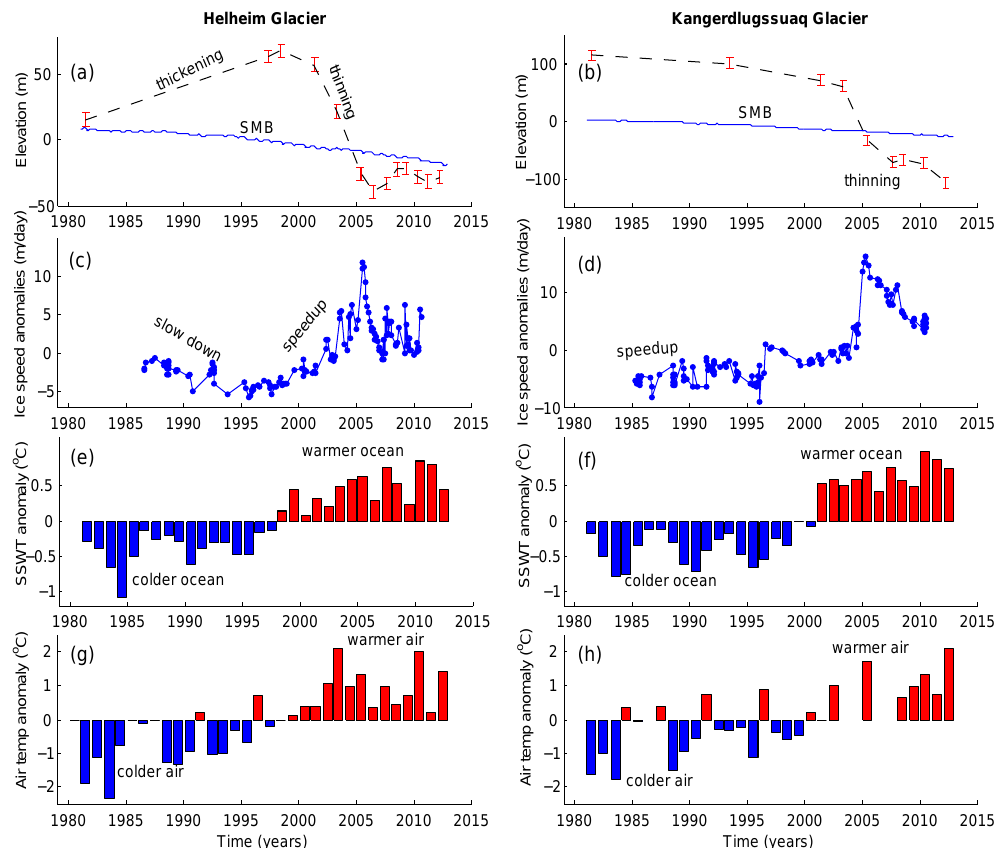
Figure 7. Time series of surface elevation change, surface velocity, sub-surface water temperature (SSWT), and air temperature. (a) : Time series of elevation change relative to 1981 of Helheim Glacier at the location marked by the white star in Fig. 4a. (b) : Same as for (a) , but for Kangerdlugssuaq Glacier. Error bars of ± 5.1m (Helheim Glacier) and ± 9.4m (Kangerdlugssuaq Glacier) are displayed in (a) and (b) , representing the combined vertical uncertainty in elevations. (c) and (d) : Surface flow speed anomalies obtained from Bevan et al. (2012) for Helheim and Kangerdlugssuaq glaciers, respectively, in myr − 1 , with the mean flow speed from 1995 to 2012 removed. SSWT anomaly in degrees Celsius at point 1 (e) and point 2 (f) (see Fig. 1a for locations) with the mean temperature during 1981–2012 removed. Air temperature anomaly in degrees Celsius at Tasiilaq (g) and at Aputiteeq (h) with the mean temperature during 1981–2012